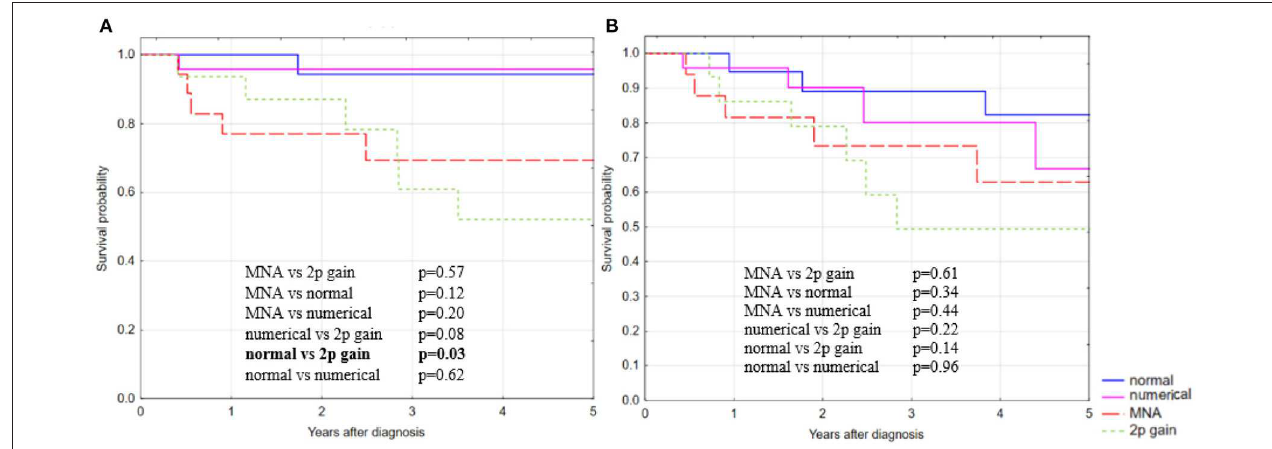
FIGURE 2 | Kaplan–Meier estimates of (A) 5-OS with statistically significant differences, and (B) 5-EFS without statistically significant differences between specific subgroups in relation to copy number status of MYCN gene.